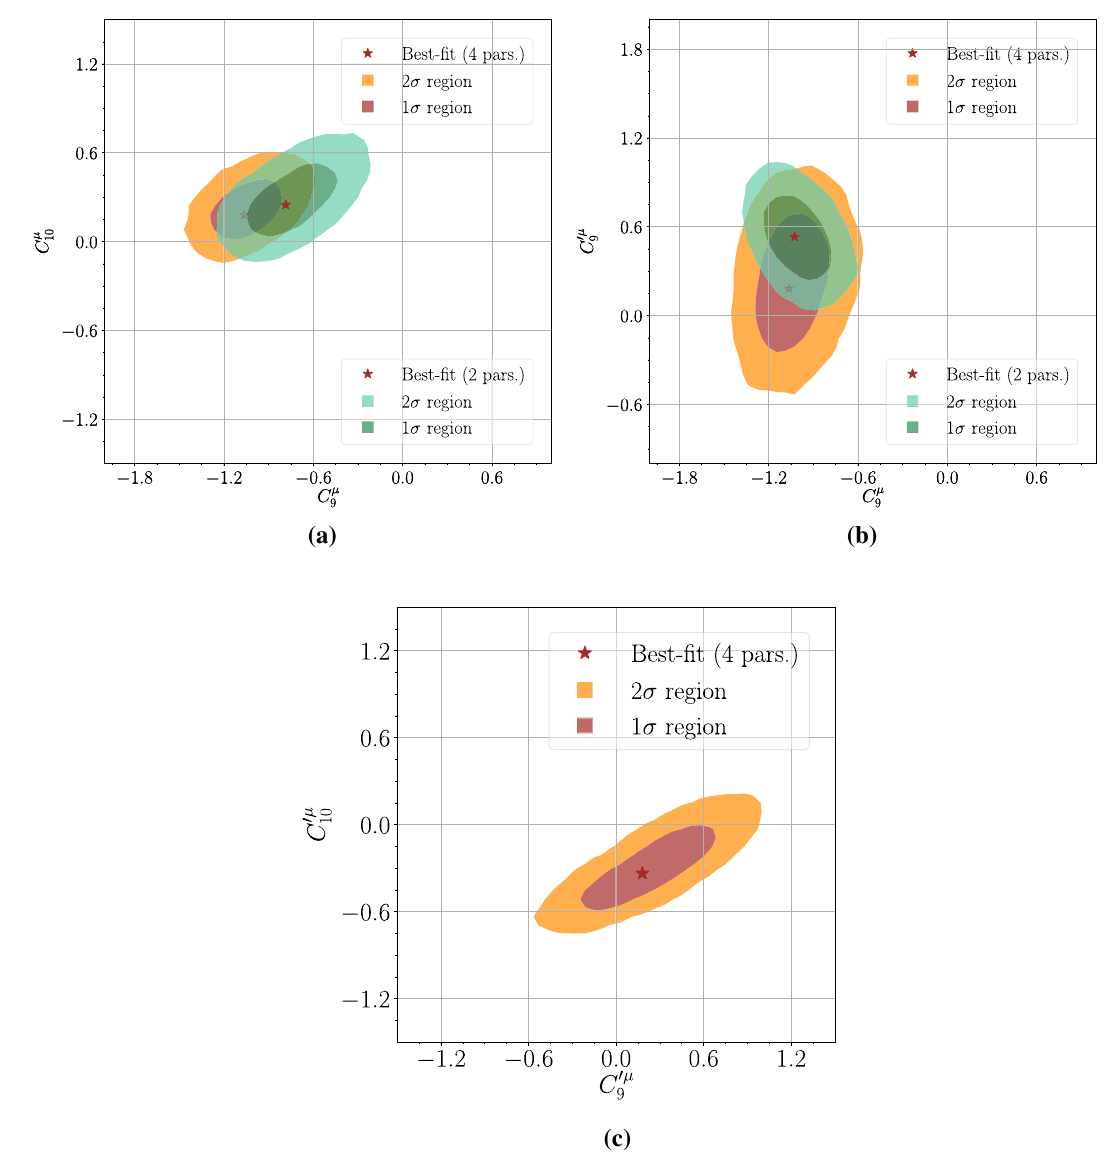
red stars mark the position of the best-fit points. b A similar comparison μ (cid:4) μ oftheposteriorpdfforthescanin C , C (shadesofgreen)andtheone 9 9 μ μ (cid:4) μ (cid:4) μ with C , C , C , C all floating (orange/brown). c The 9 10 9 10